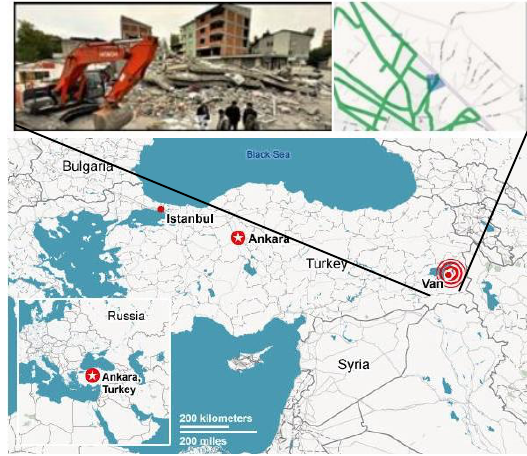
Figure 1: The map of the study area (Van city centre) with the streetview data taken after the earthquake.